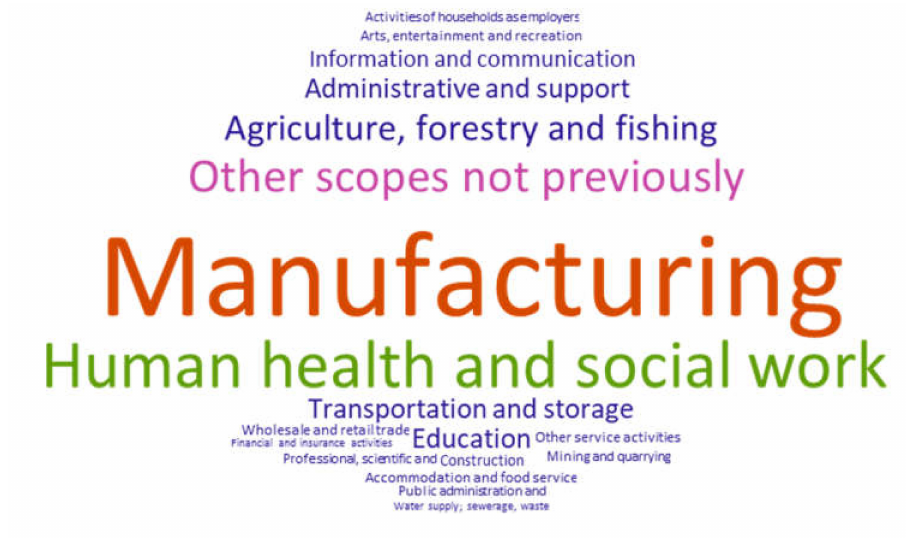
Figure 4. Knowledge categories and